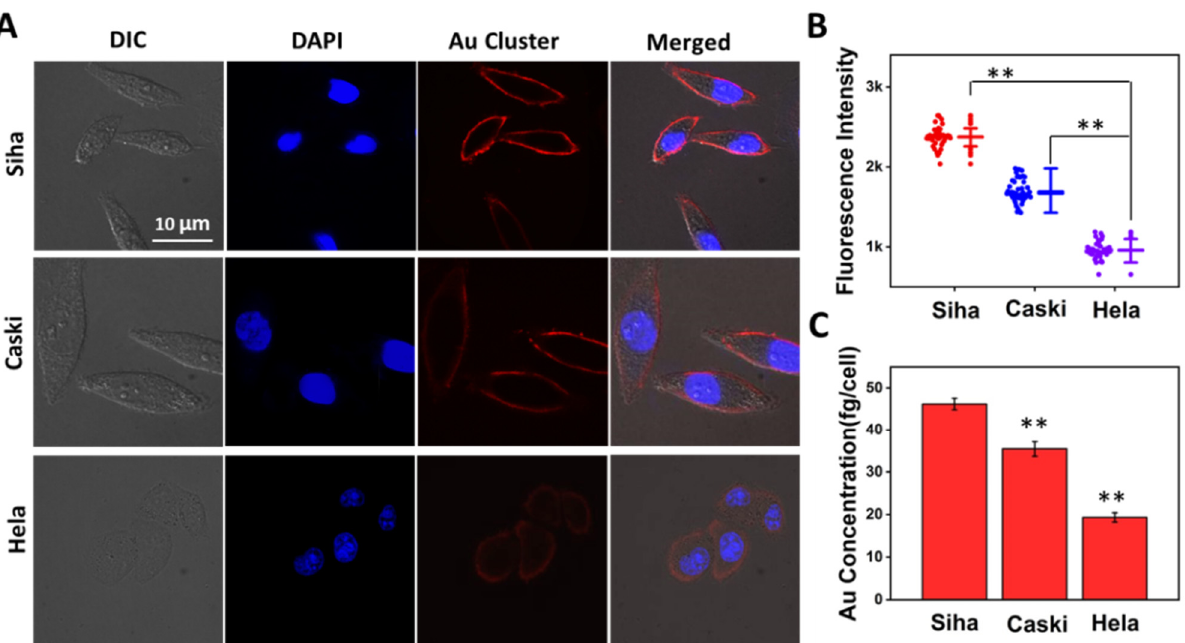
Figure 6. Quantitatively distinguish cervical cancer cells with different invasion/metastasis capabil- ities. ( A ) Human cervical cancer Siha, Caski and Hela cells were exposed to 8 µ M Au clusters for 0.5 h. ( B ) Fluorescence intensity analysis corresponds to A. Data on the left cell line represent the fluorescence intensity for each of the 50 cells selected, and data on the right represent the average fluorescence intensity and standard deviation for the 50 cells, respectively. ( C ) The average Au mass on each cell was quantified by ICP-MS. ** p < 0.01.